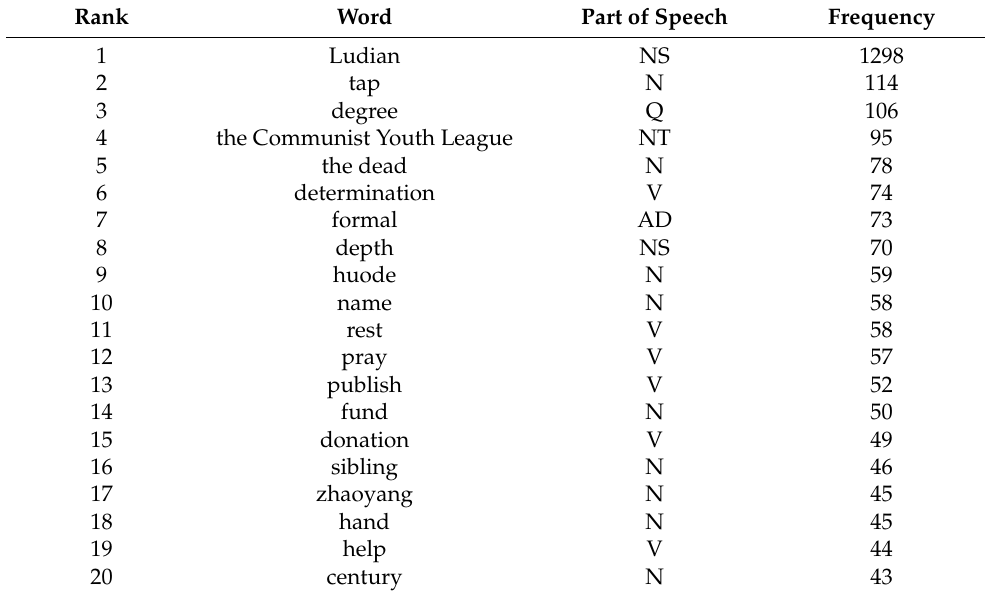
Table 10. Top 20 words in the recommended list of the Ludian